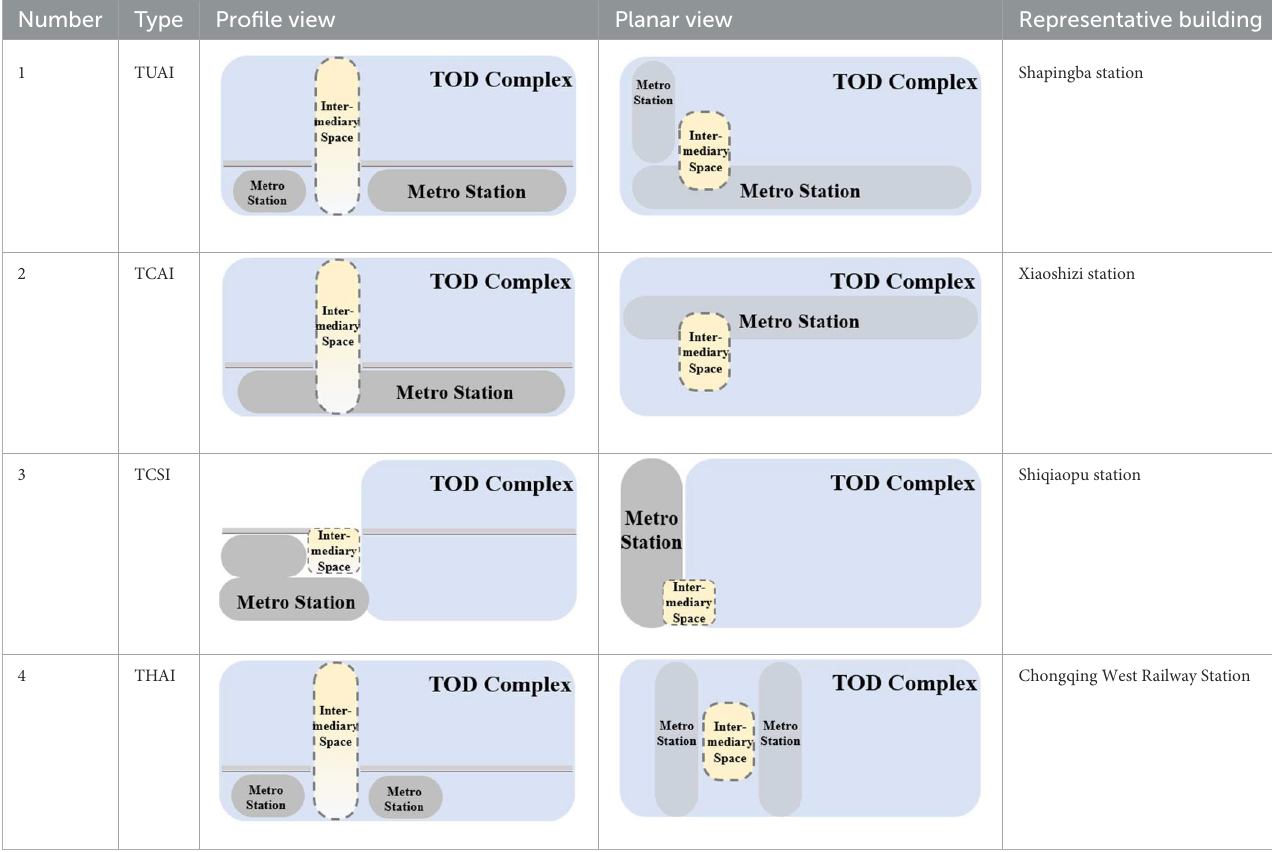
TABLE 5 Position of four types of underground open intermediary space in TOD